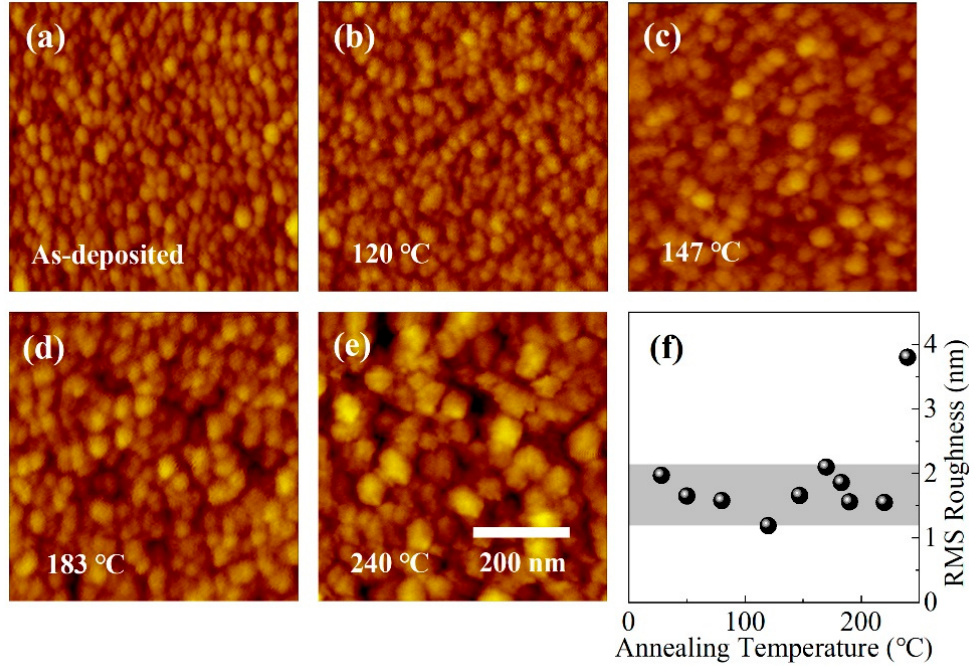
Figure 1. ( a – e ) AFM images of SnTe films annealed at various temperatures. The SnTe films were sputtered on Si/SiO 2 substrates at room temperature and then annealed in vacuum for two hours. All films are 50 nm in thickness. ( f ) Root mean square (RMS) roughness of SnTe films as a function of annealing temperature.